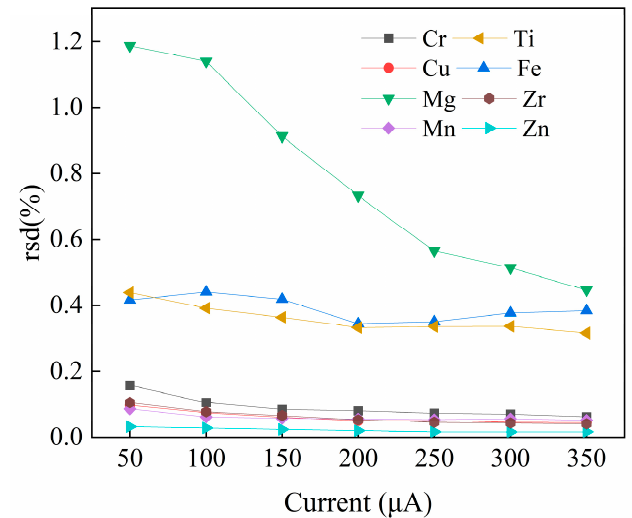
Figure 5. Standard deviation under different currents measured by X-ray tubes.